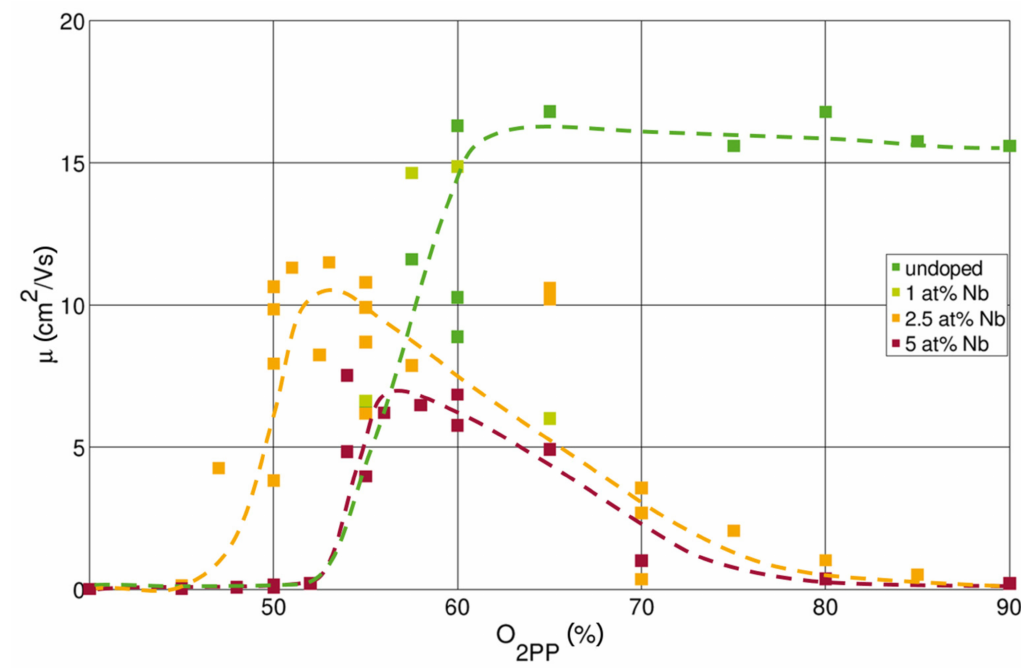
Figure 4. Mobilities µ as a result of O 2PP and the doping concentration with lines as guidance to the eye. The resistivity and charge carrier density n for these samples are shown in Figures 1 and 2. In the undoped case, the mobility arises and finally saturates upon increasing the amount of oxygen. Conversely, if Nb is present, the mobility drops drastically when adding more